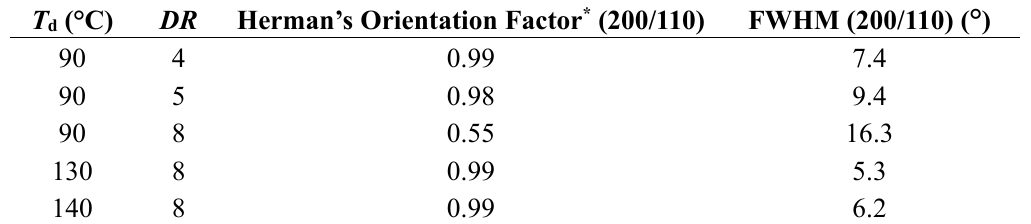
Table 5. Crystalline orientation of various PLLA tapes obtained by Wide-angle X-ray scattering